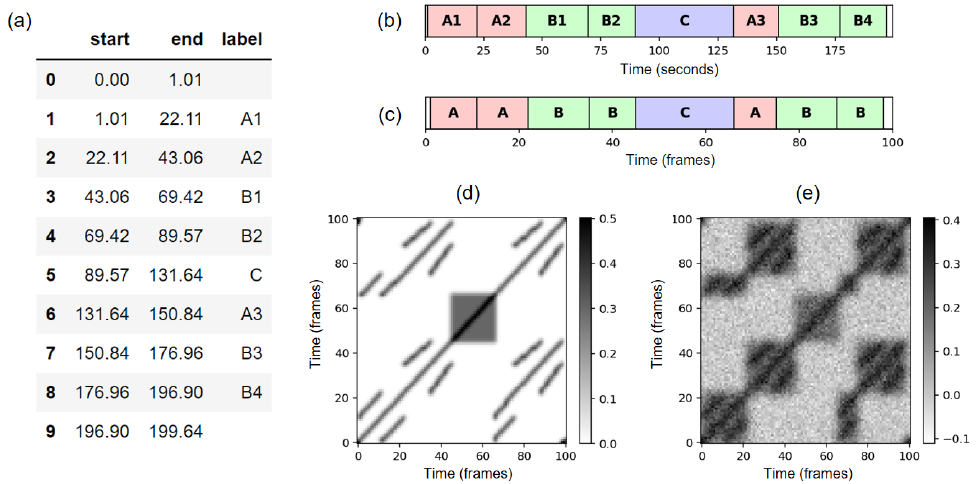
Figure 12. ( a ) Structure annotation (given as a CSV file) for a recording of Brahms’ Hungarian Dance No. 5. ( b ) Visualization of structure annotation (time axis given in seconds). ( c ) Visualization of converted structure annotation (time axis given in frames). ( d , e ) Different SSMs generated synthetically from the structure